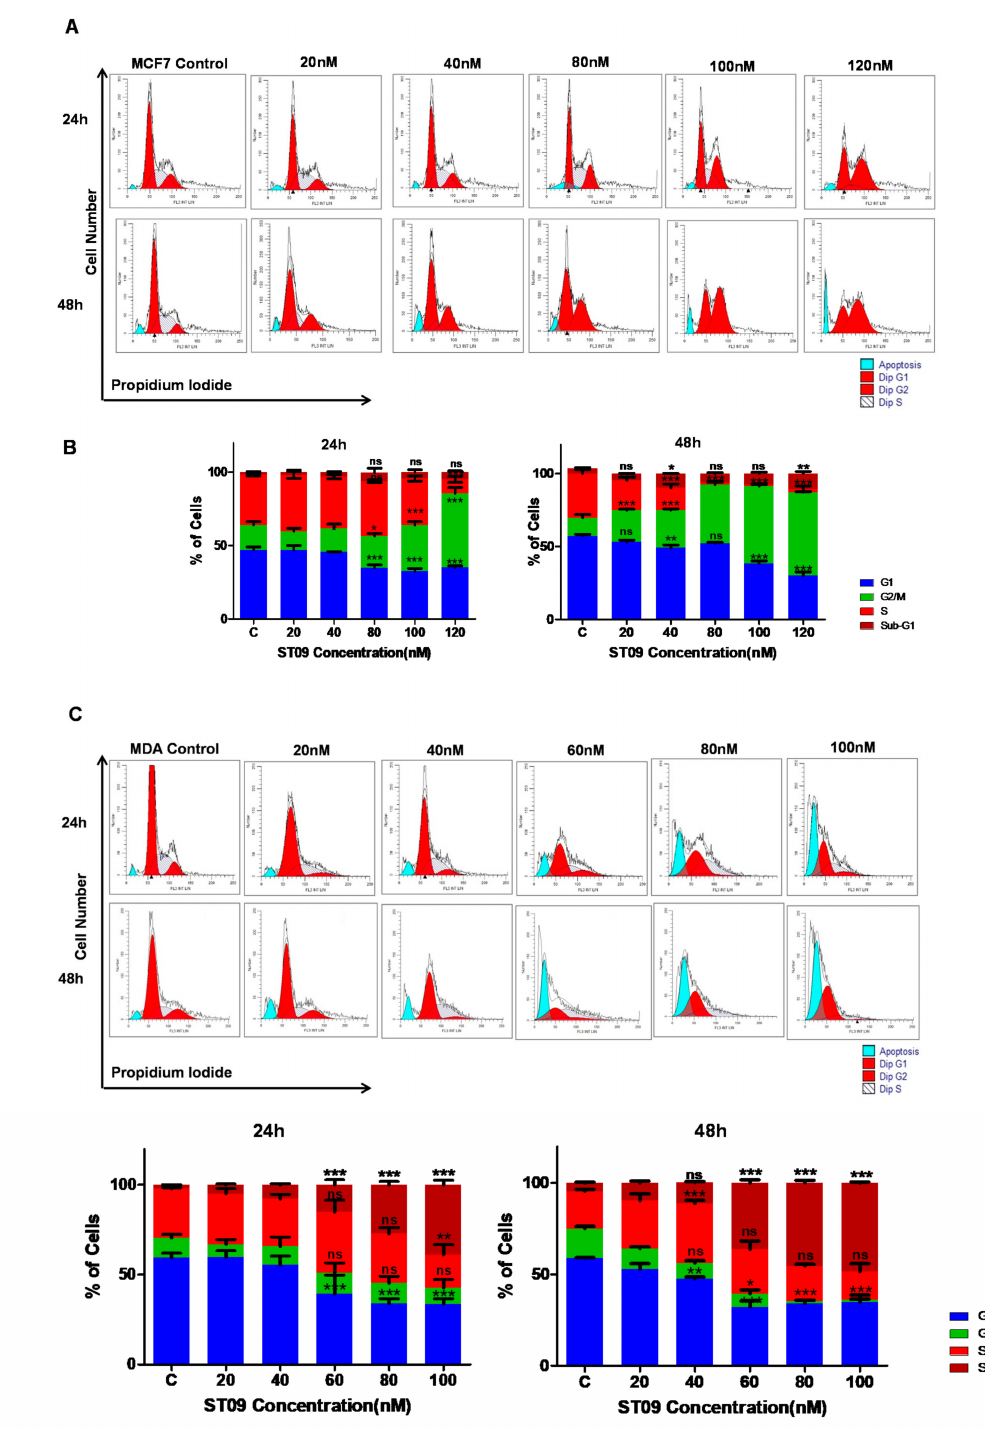
Figure 3. Impact of ST09 on the cell cycle in breast cancer cells: cell cycle profile of MCF7 ( A ), and MDA-MB-231 cells ( C ) at 24 and 48 h. Quantification of the percentage of cells in each phase of the cell cycle MCF7 ( B ) and MDA-MB-231 ( D ) cells is depicted as a bar graph of mean ± SEM at 24 and 48 h. Each experiment was done in triplicate and represented as histograms. A two-way ANOVA test was performed, and the p -value was calculated between control and ST09 treated groups (* p < 0.05, ** p < 0.005, *** p < 0.0001, ns =